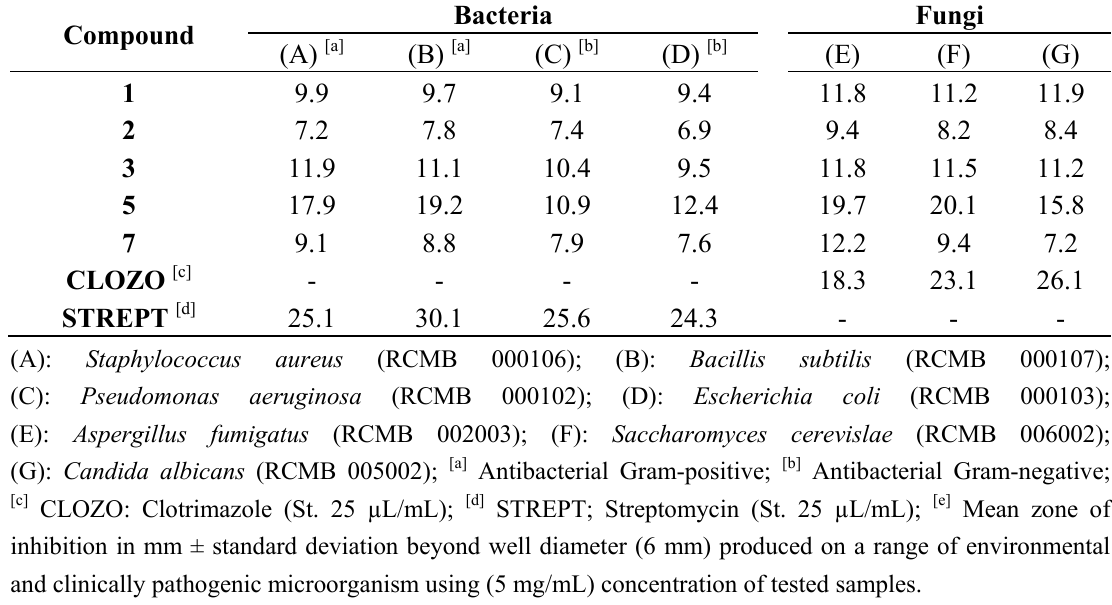
Table 1. Antimicrobial activity (inhibition zones in mm) of some of compounds 1 – 10 [e] . Bacteria Compound